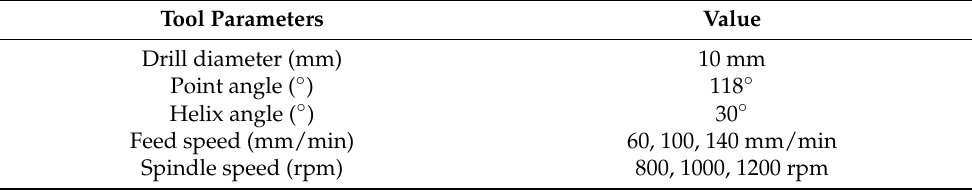
Table 1. Drill bit geometry and cutting parameters used in the simulation.